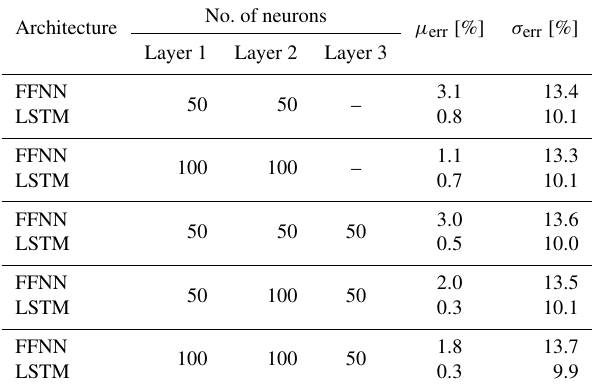
Table 1. Representative grid search for best architecture of the first network using feed-forward neural networks (FFNNs) and LSTM with lag = 29s and tanh activation function in between the hidden layers. Both FFNN and LSTM trained using the Adam optimization algorithm and mean absolute error loss function. The listed percent- age error estimation with mean µ err and standard deviation σ err is y prediction − y observation × based on the validation dataset where y observation